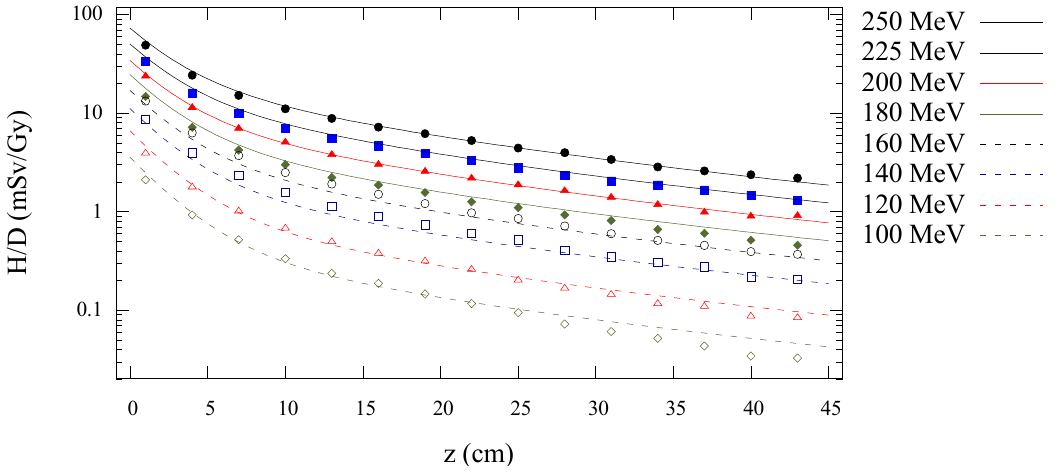
Figure 4. Predictions from Monte Carlo (points) and analytical model (lines) of neutron equivalent dose per treatment dose (𝐻/𝐷) values versus depth in water from proton beams for 100, 120, 140, 160, 180, 200, 225, and 250